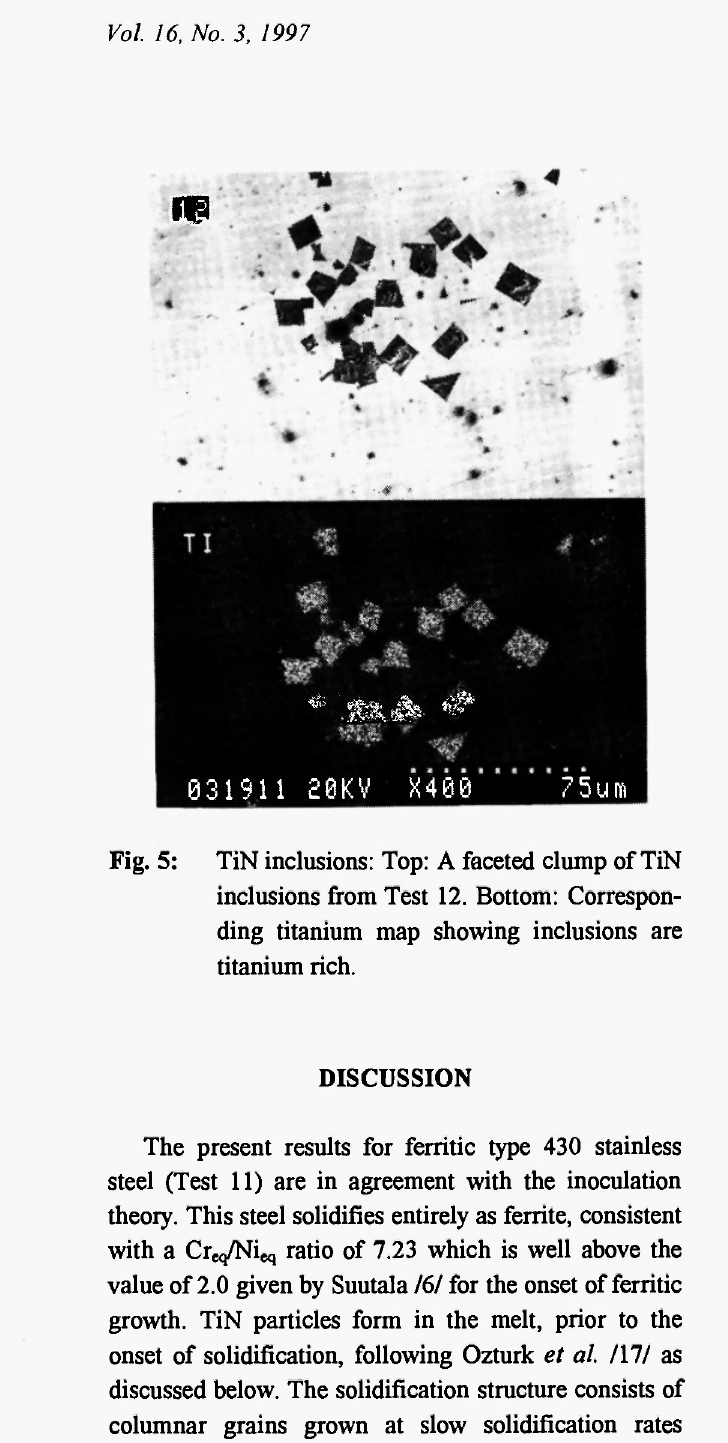
TiN inclusions: Top: A faceted clump of TiN inclusions from Test 12. Bottom: Correspon- ding titanium map showing inclusions are titanium